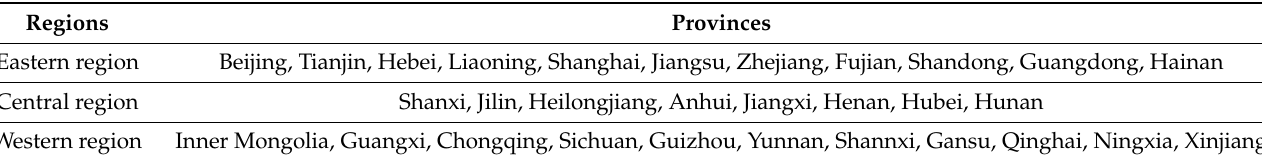
Table 3. Global Moran’s I index and Z statistics of China’s EIICI from 2000 to 2019.